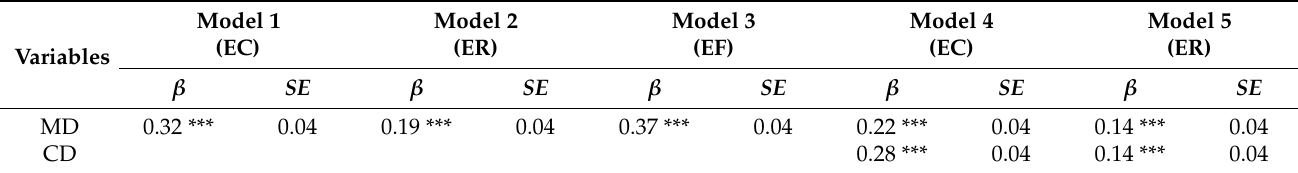
Table 2. Results of the regression analysis ( n =